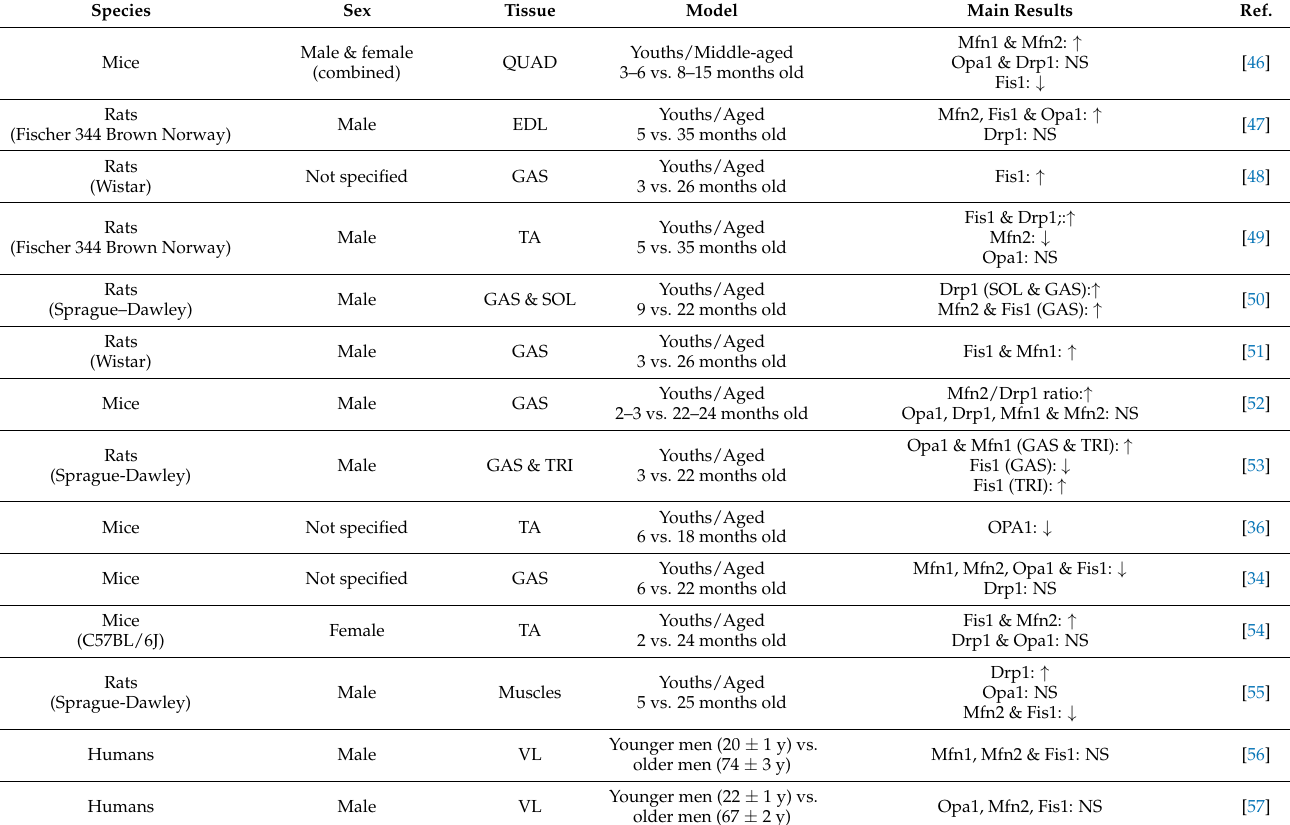
Table 1. Compilation of studies that have investigated the impact of aging on the expression or content of proteins regulating mitochondrial